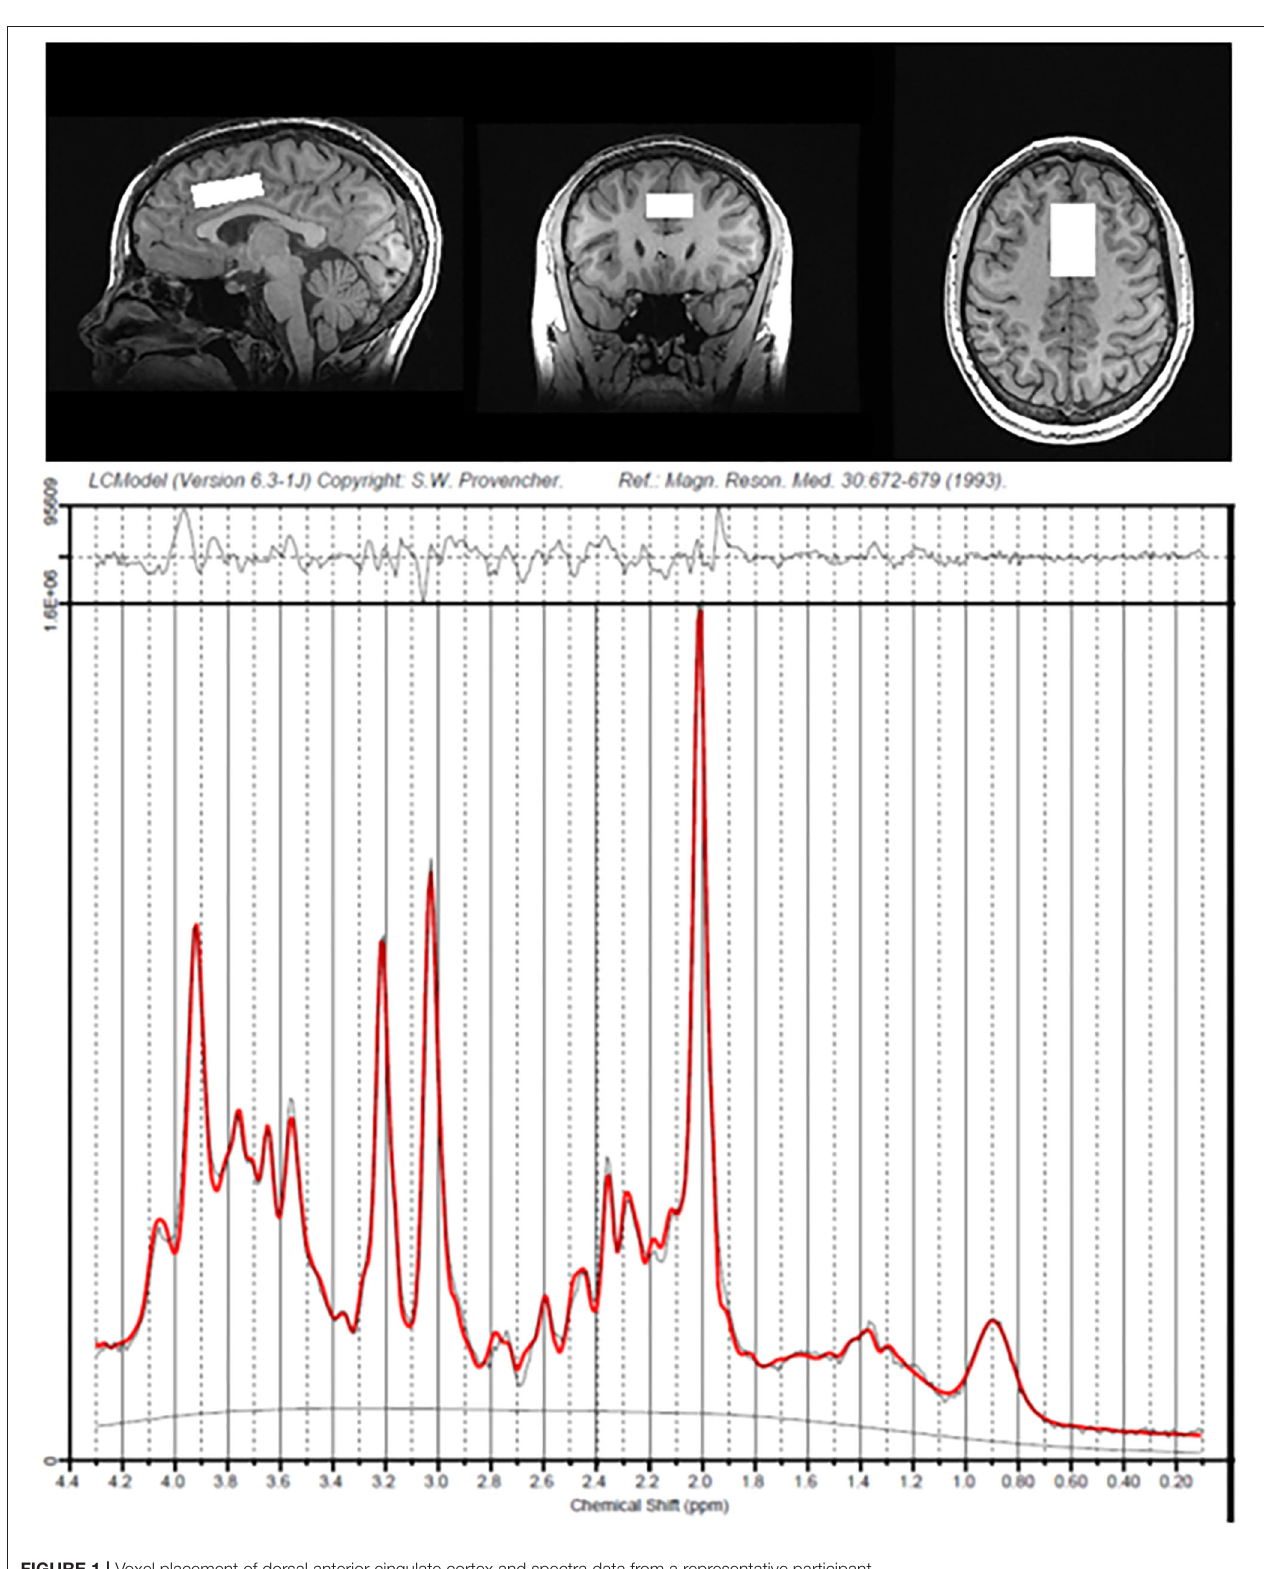
Frontiers in Psychiatry |